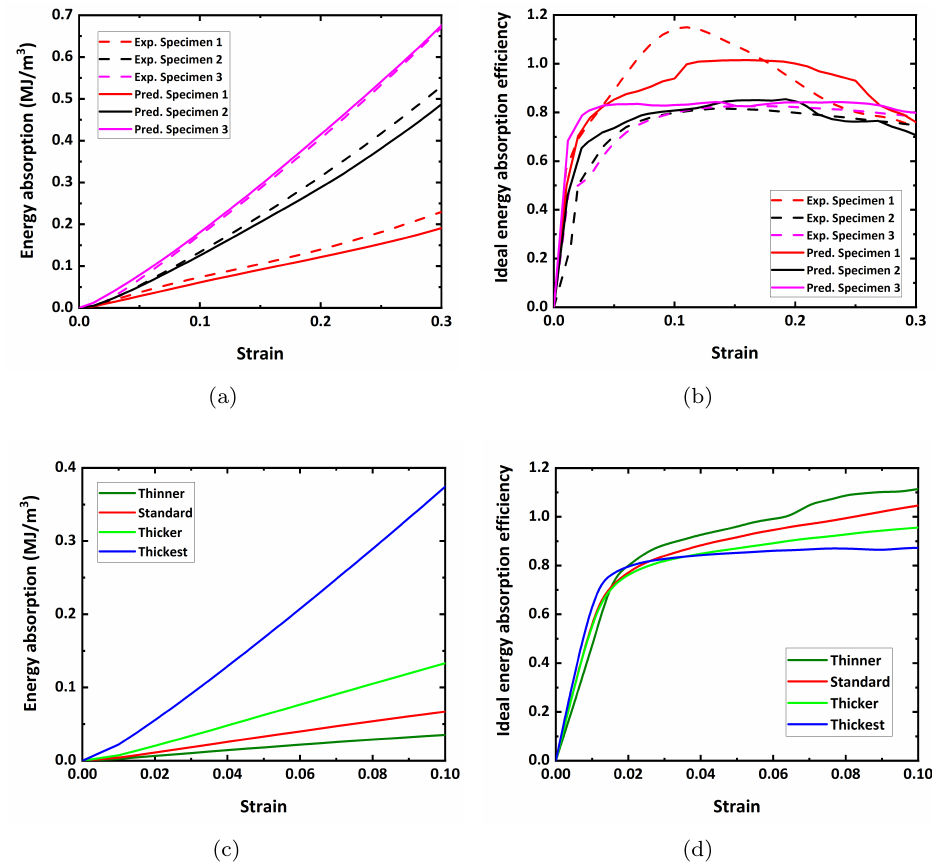
Figure 15. ( a ) Energy absorption and ( b ) ideal energy absorption efficiency of experiments and Figure 15: (a) Energy absorption and (b) ideal energy absorption efficiency of experiments predictions according to different porosity. ( c ) Energy absorption and ( d ) ideal energy absorption and predictions according to different porosity. (c) Energy absorption and (d) ideal energy efficiency of various model domains with different strut absorption efficiency of various model domains with different strut thickness